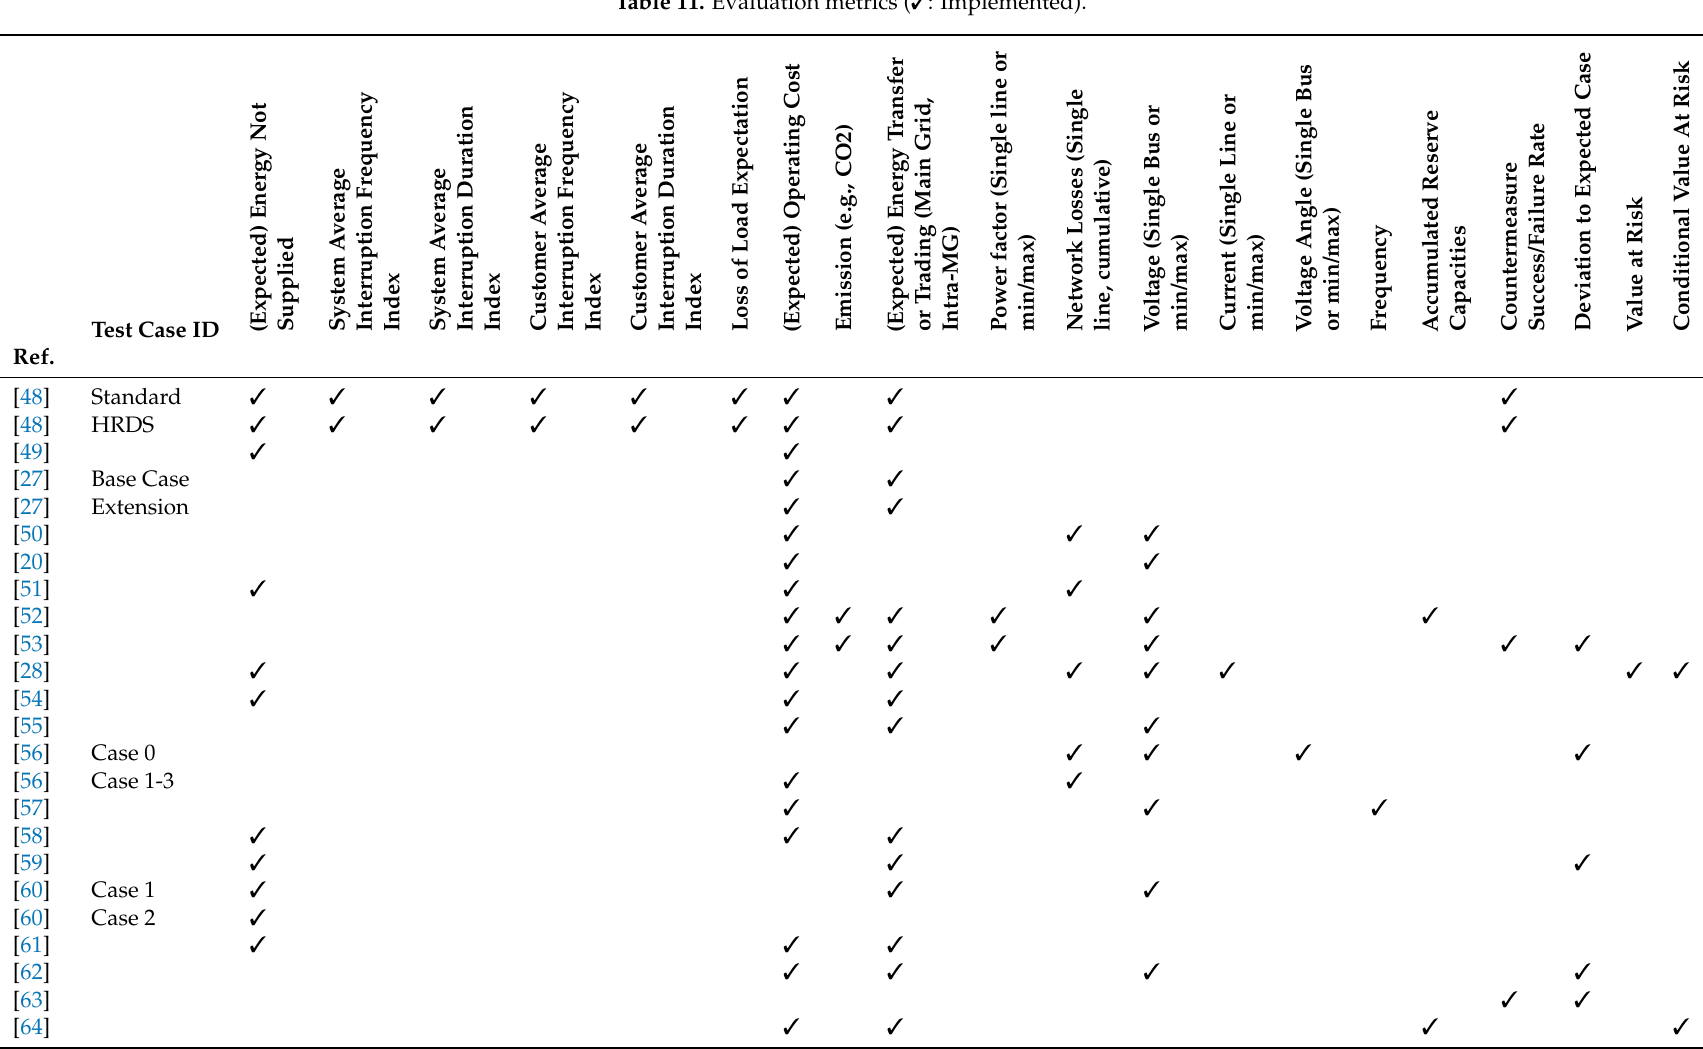
Table 11. Evaluation metrics ( (cid:51) :